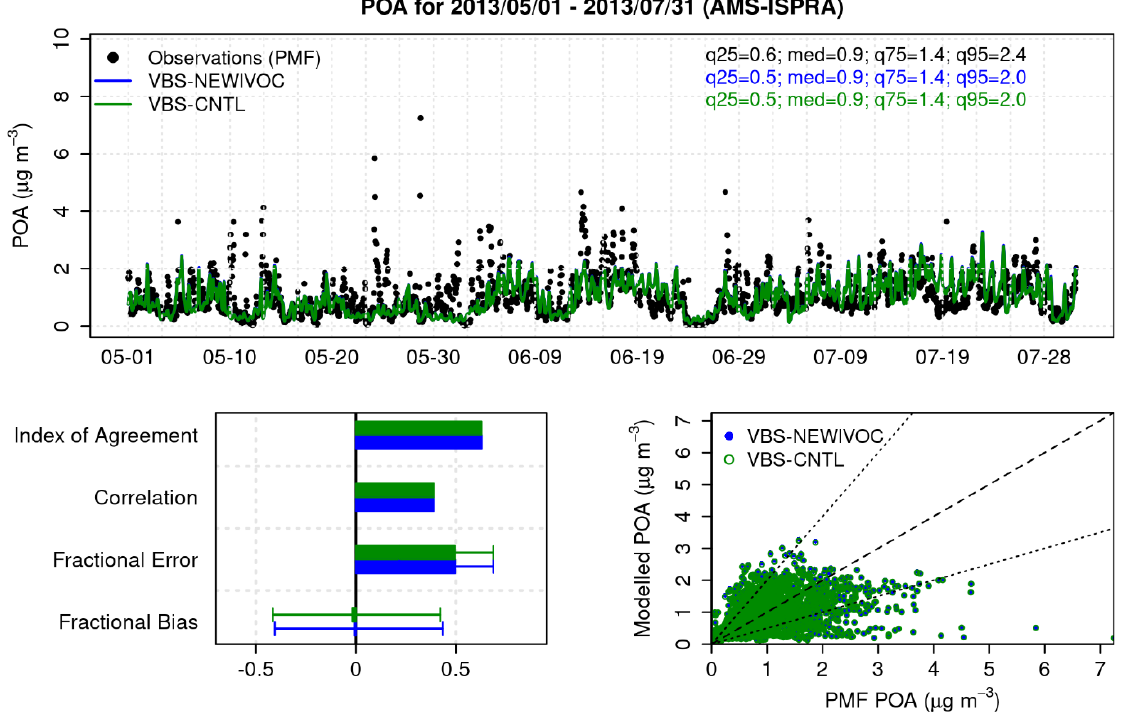
Figure 3. Comparison among modeled and observed (PMF results, black) POA concentrations in May – July 2013 at the Ispra site: VBS base scheme (VBS-CNTL, green) and VBS scheme with new parameterizations for IVOC emissions (VBS-NEWIVOC, blue).